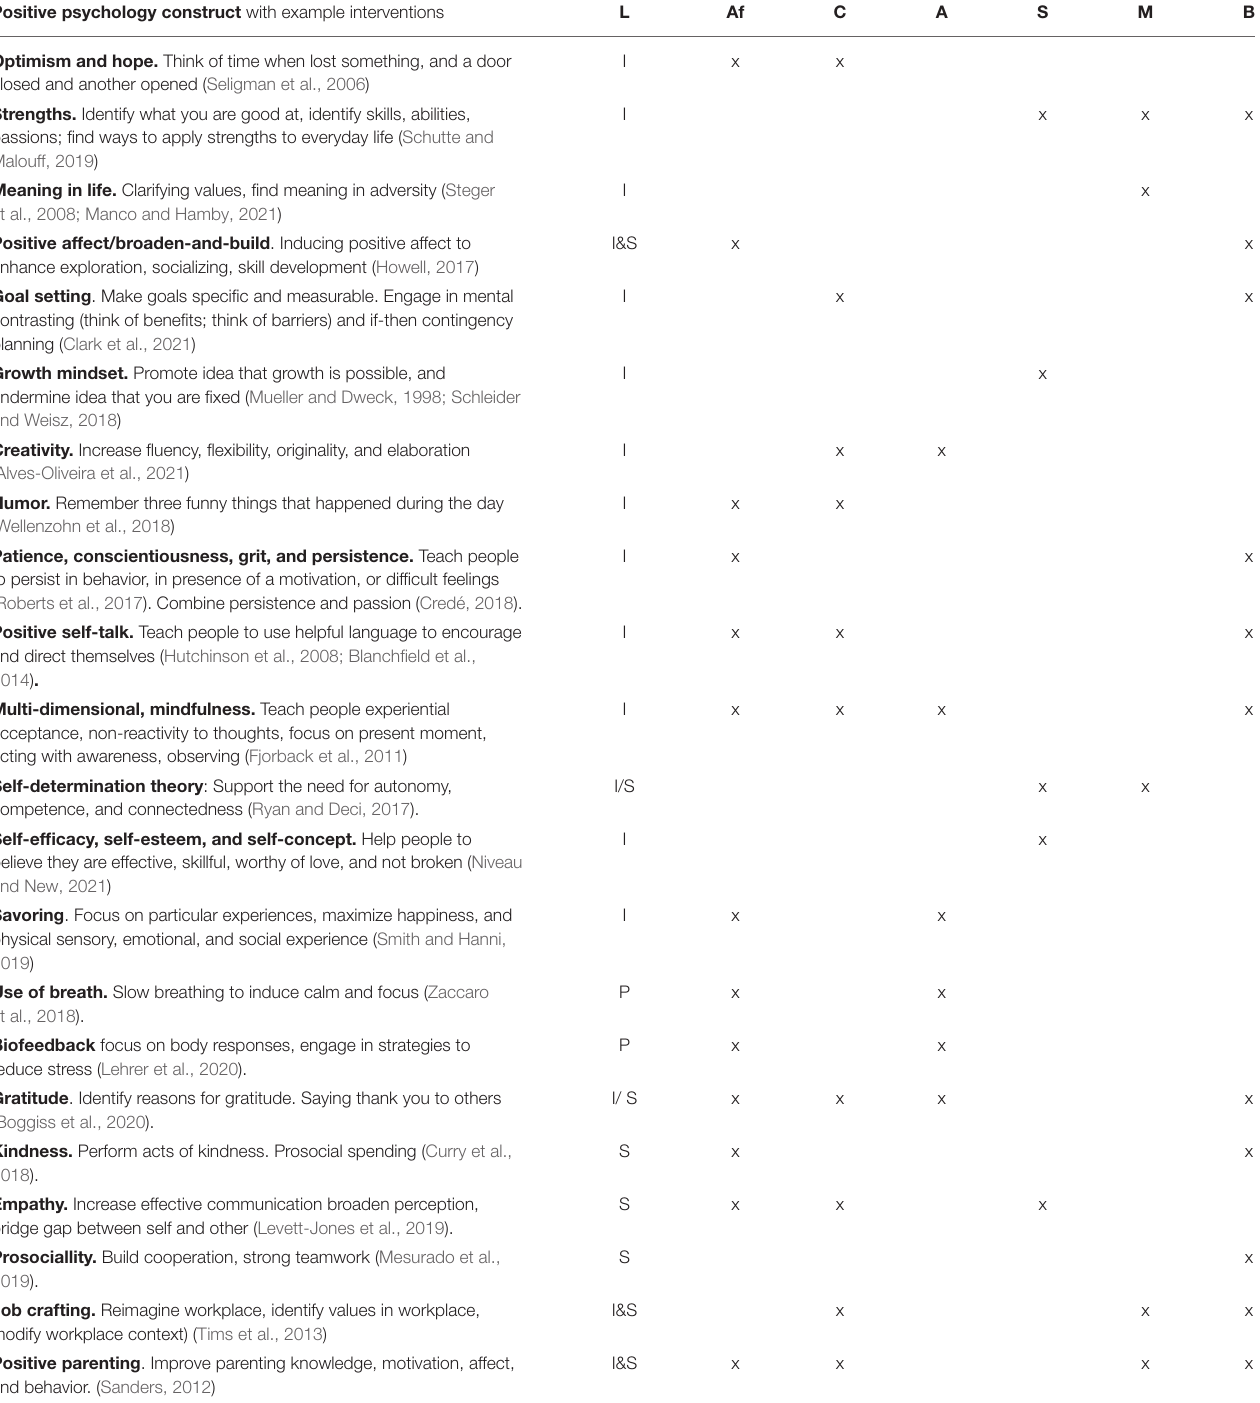
TABLE 2 | Positive psychology constructs and associated processes in positive